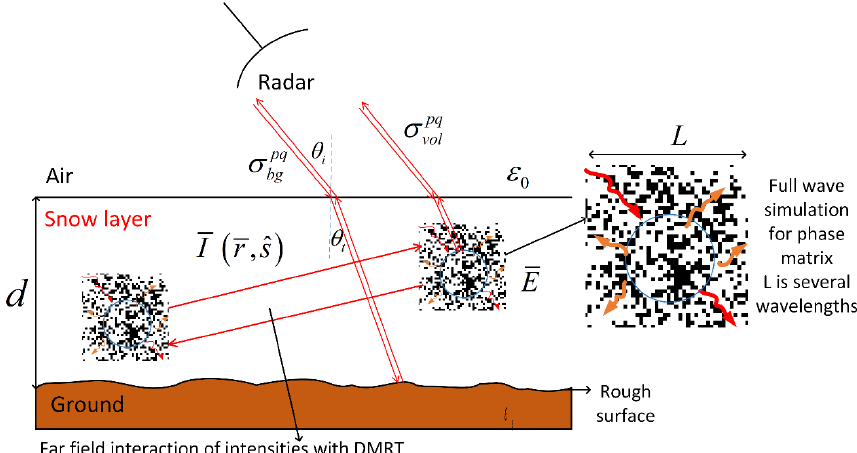
Figure 1. Main contributions to radar scattering from snow-covered ground. Scattering at air–snow interface is neglected, and the snow layer is assumed homogeneous. The snow depth is d ; ε 0 is the air permittivity, and ε g is the soil permittivity. θ i is the incident angle of radar. E(r ) is the internal electrical field, and I (cid:0) r, ˆ s (cid:1) is the specific intensity within the